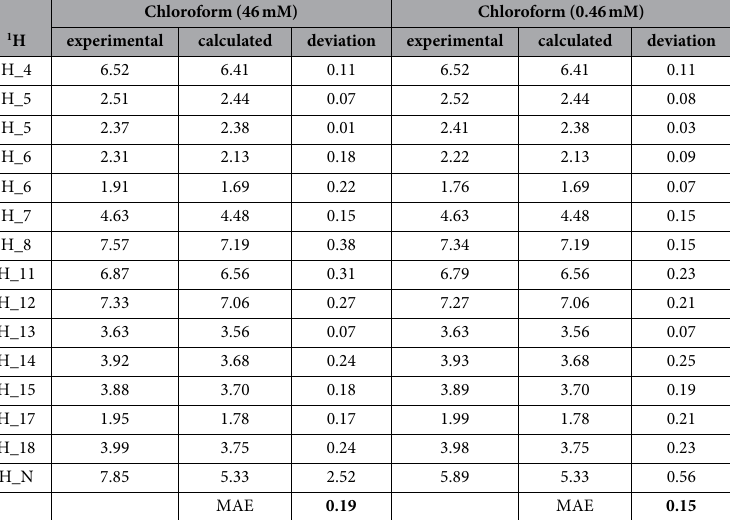
Table 4. Comparison of DFT calculated and experimentally measured chemical shifts at 46 mM and 0.46